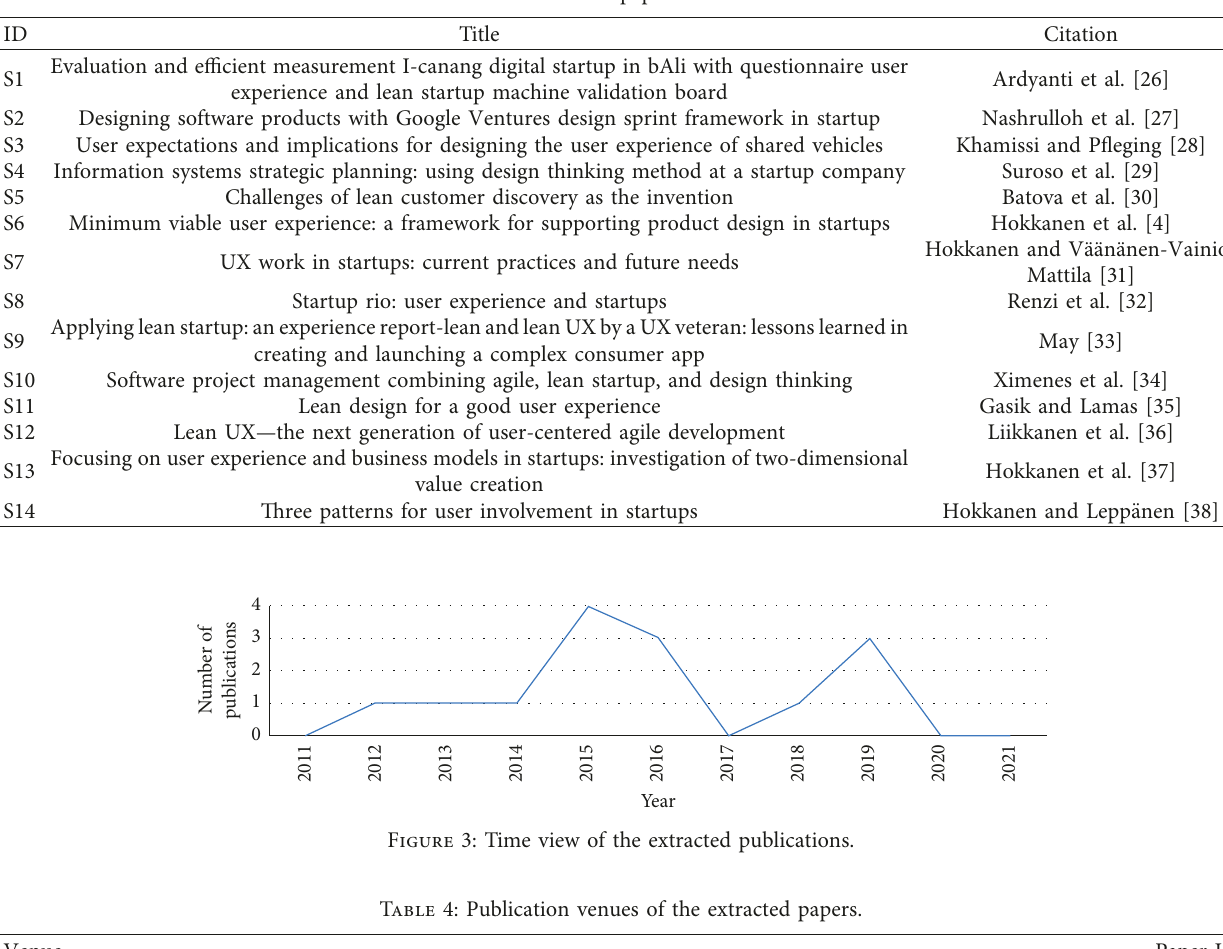
Table 3: List of papers extracted.